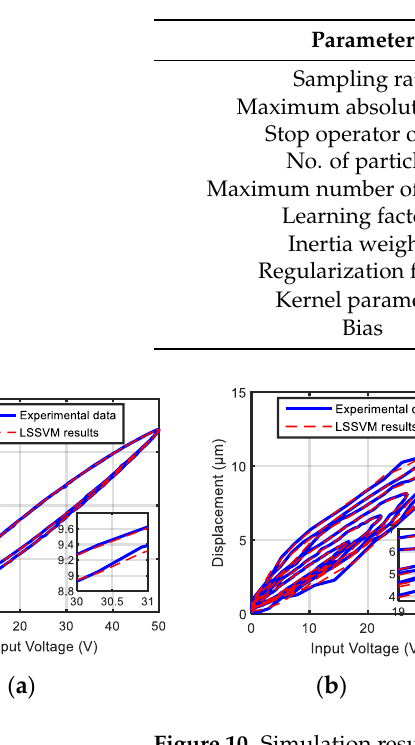
Table 3. The selected and identified hysteresis model parameters.